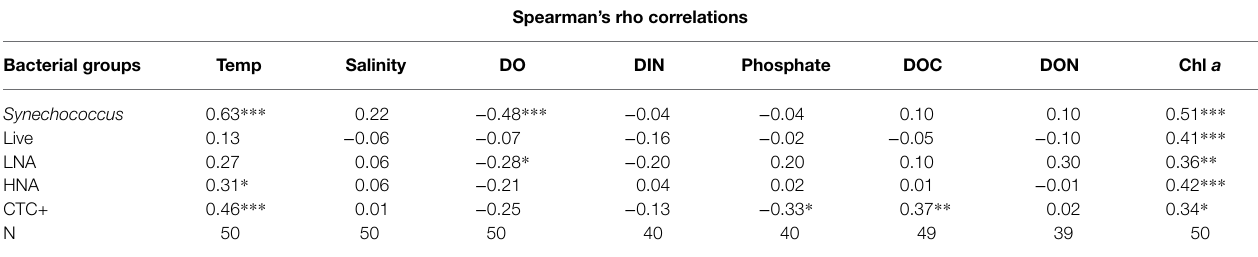
TABLE 1 | Spearman correlation coefficients (rho) between bacterial population abundances (cells mL − 1 ) and selected environmental and nutritional factors: Temp (temperature, ° C), salinity, DO (dissolved oxygen, mg L − 1 ), DIN (dissolved inorganic nitrogen, μ mol L − 1 ), phosphate ( μ mol L − 1 ) DOC (dissolved organic carbon, μ mol L − 1 ), DON (dissolved organic